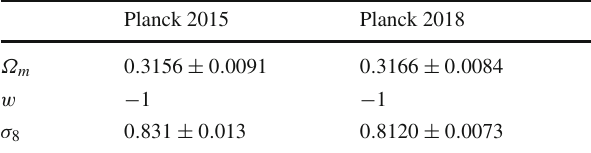
Table 1 Planck 2015 [17] and 2018 [16] (TT,TE,EE + lowE) best fit Λ CDM